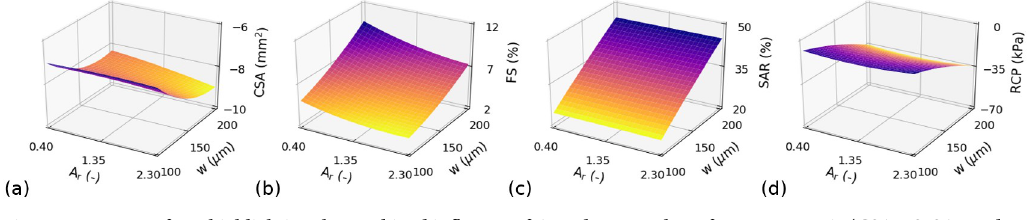
and w on each performance metric ( CSA , FS , SAR and r